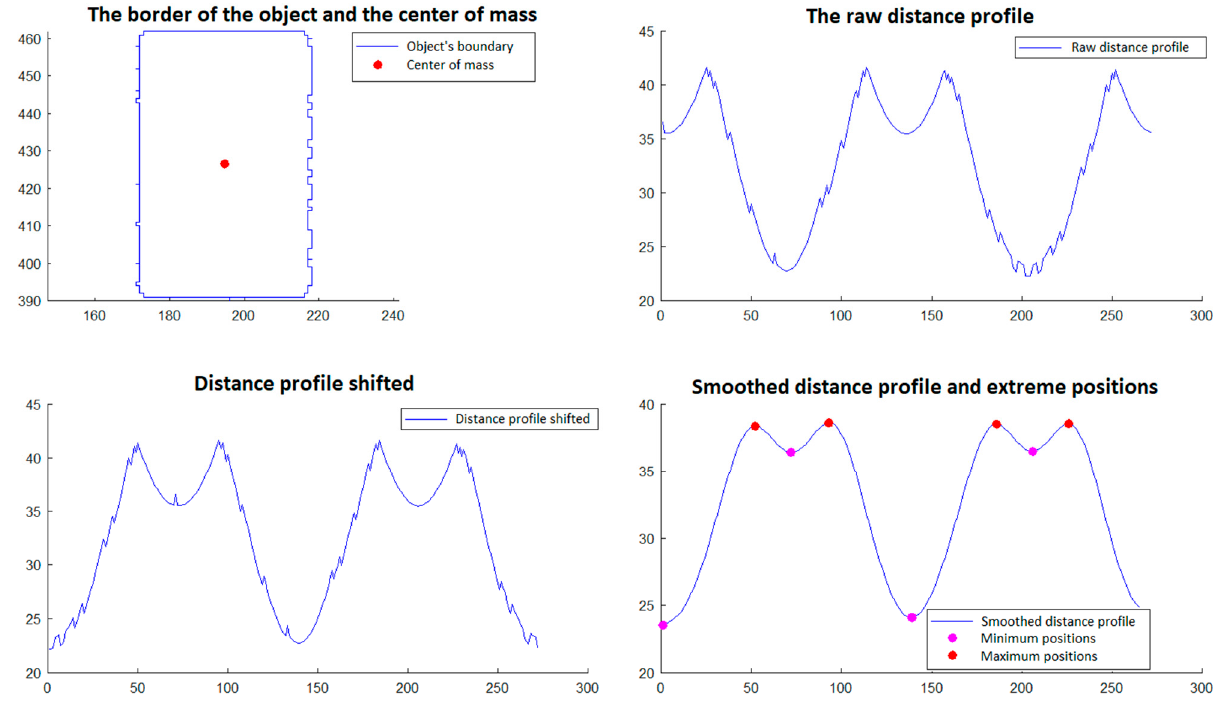
Figure 14. Triangular object selection procedure (step 5): non-triangular object.